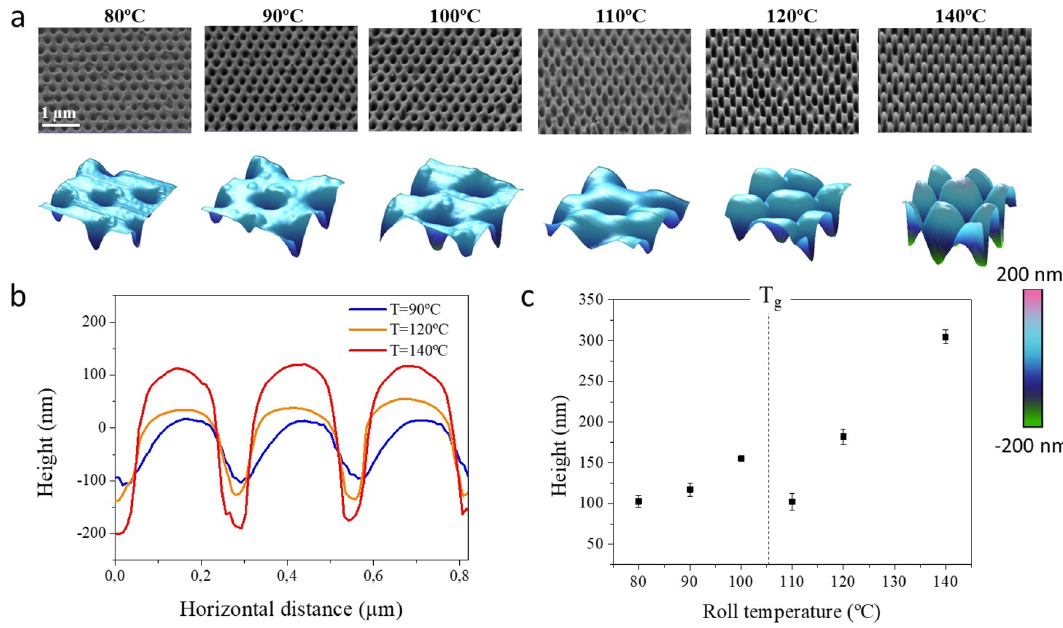
Figure 4. ( a ) SEM images of PMMA R2R nanoimprinted moth-eye structures fabricated at web speed of 0.5 m·min −1 and different temperatures as indicated. SEM images were acquired at a tilting angle of 45° with an equivalent rotation angle in all cases. The bottom row shows 3D reconstruction of AFM height images of areas ca . 550 × 550 nm 2 . ( b ) AFM surface profiles corresponding to selected substrates processed at the indicated temperatures. ( c ) Height dependence of the nanofeatures with processing